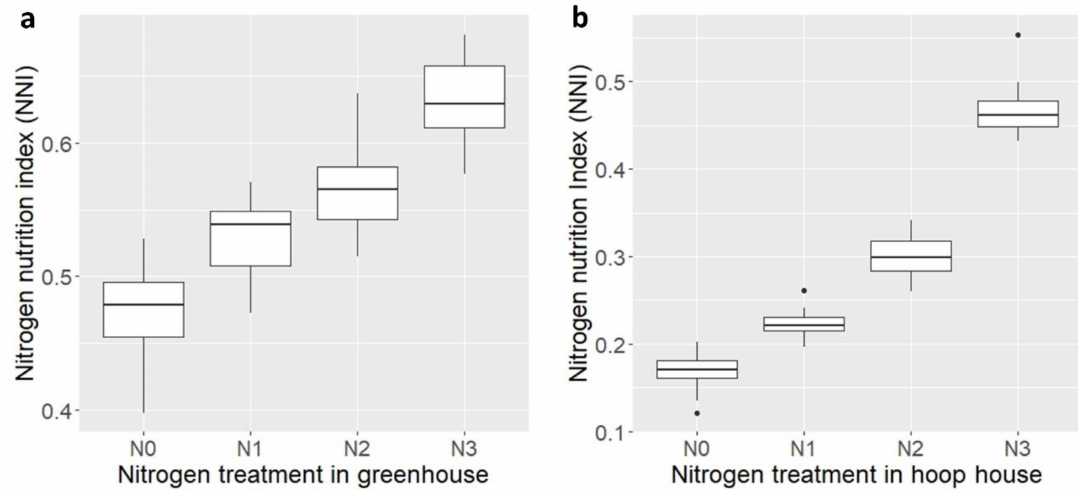
Figure 3. Boxplot of four di ff erent nitrogen treatments for the nitrogen nutrition index (NNI) of 20 wheat lines evaluated in greenhouse ( a ) and hoop house ( b